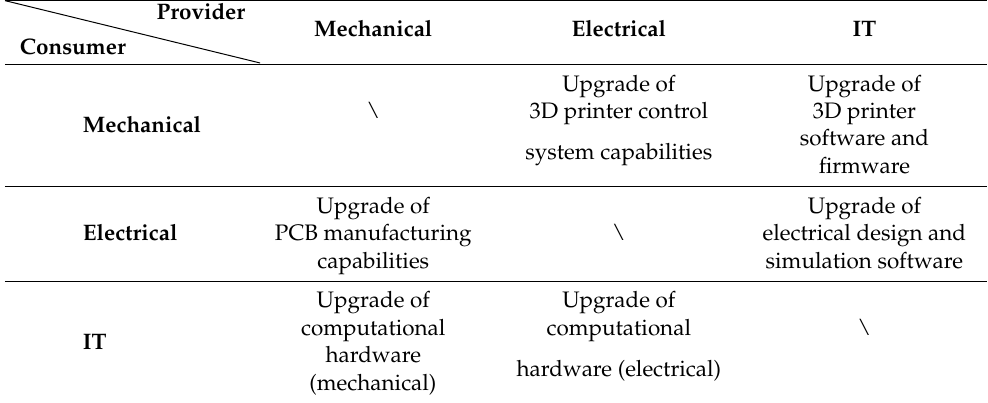
Table 3. Examples of service exchange between three types of companies in the case of 3D printing. Provider Mechanical Electrical IT Consumer